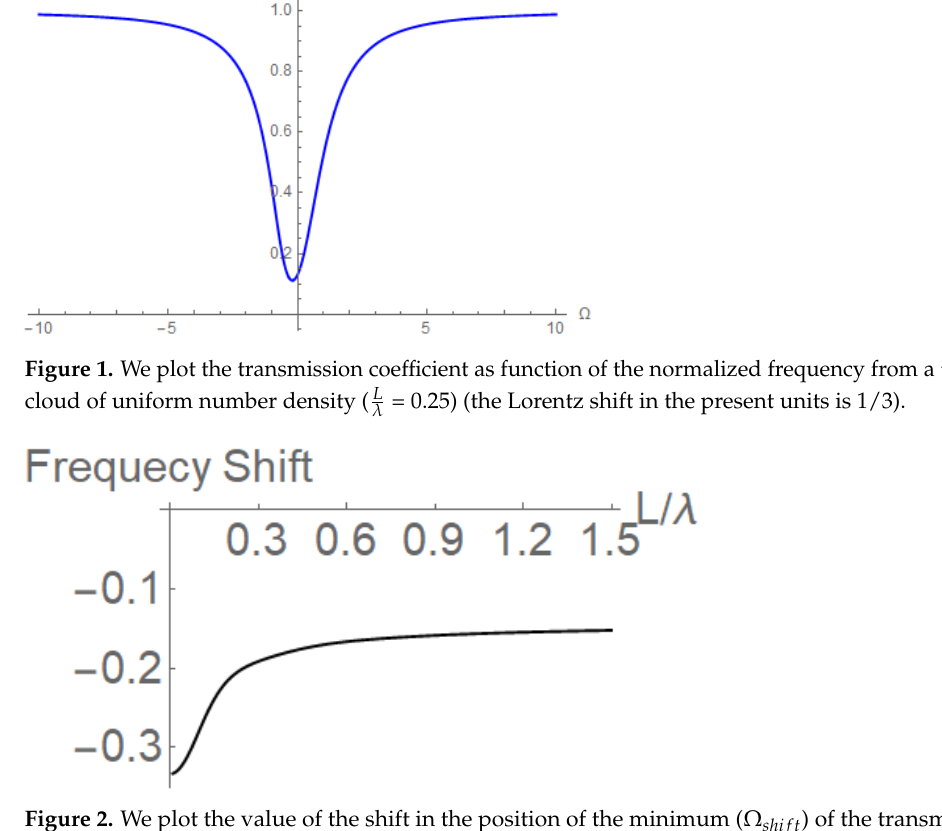
Figure 2. We plot the value of the shift in the position of the minimum ( Ω shift ) of the transmission coefficients as a function of L , the length of the cloud (thickness of the